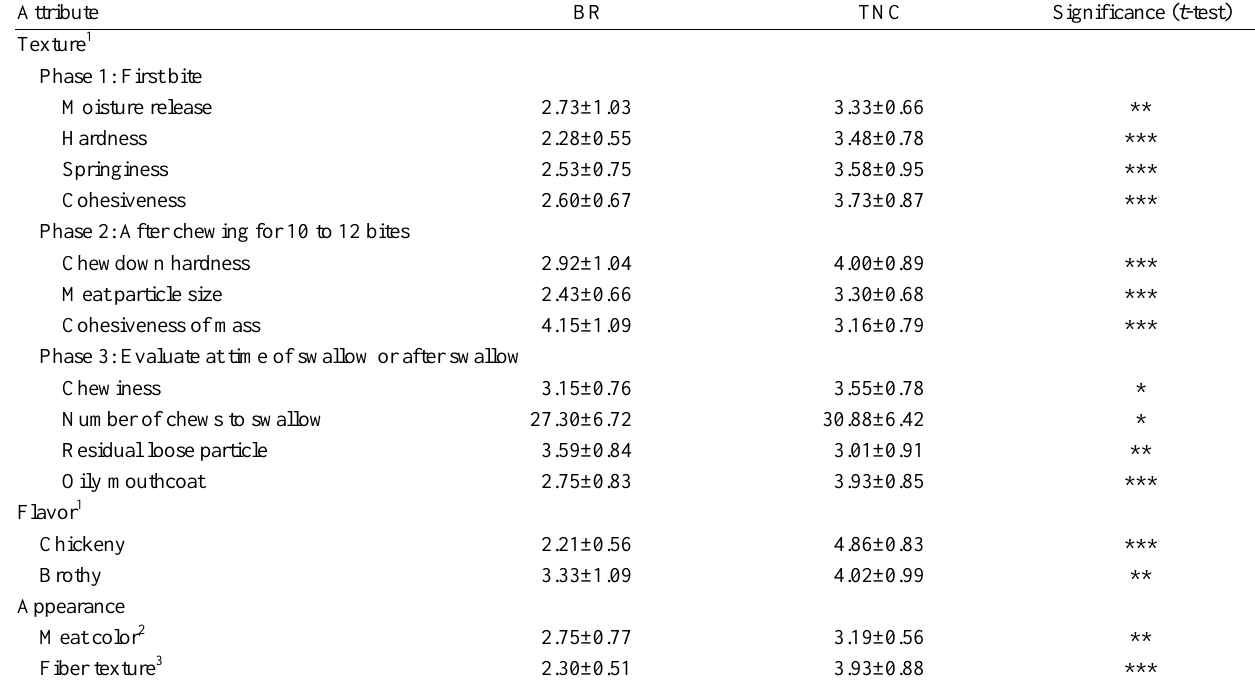
Table 3. Descriptive sensory attributes of cooked broiler (BR) and Taiwan native chicken (TNC) breast meat